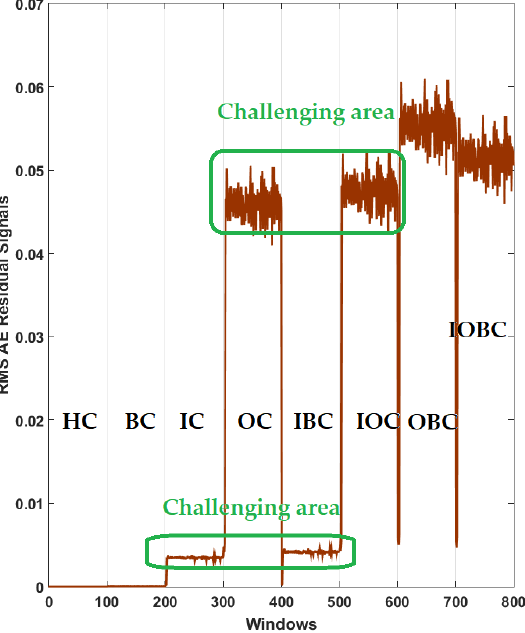
Figure 11. RMS of the resampled AE residual signals for crack type diagnosis in normal and abnormal conditions using the ALSGL-SBI technique.